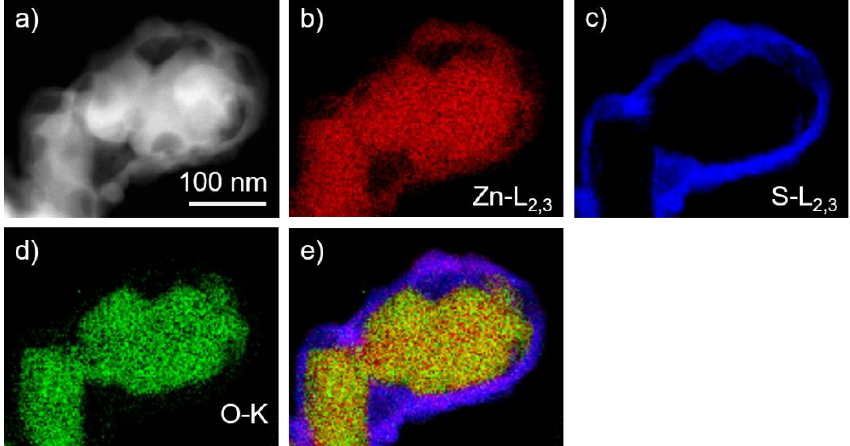
Figure 3. ( a ) HAADF-STEM image of ZnO/ZnS core – shell nanoparticles with corresponding Zn – L 2,3 , ( b ) S – L 2,3 , ( c ) O – K, ( d ) EELS spectrum images, and map ( e ) with superimposed ( b – d ) elemental maps.